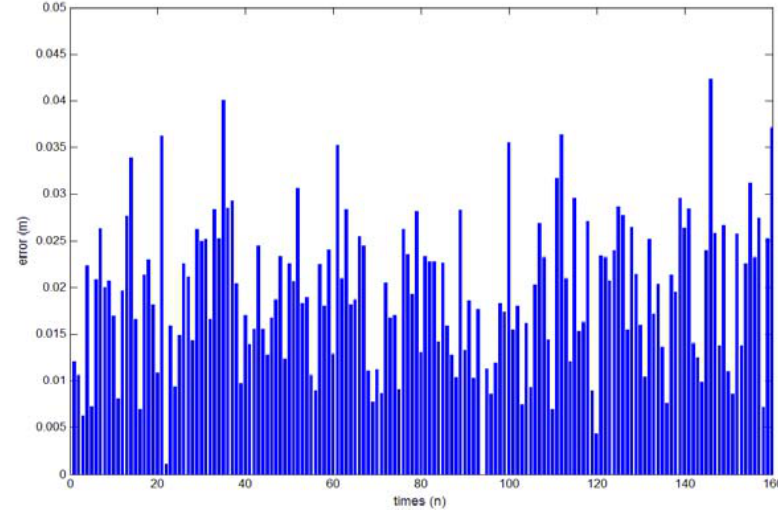
Figure 13. Position error result.